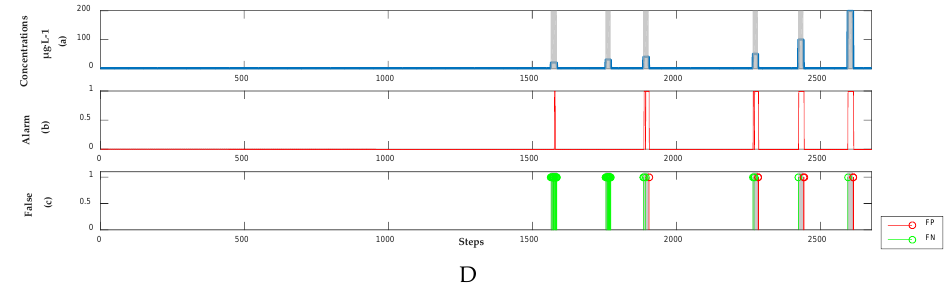
Figure 12. Detection results of the semi-supervised model without baseline drift correction. (Panel ( A )) The concentrations, alarm signals and FP points and FN points of phenol; (Panel ( B )) The concentrations, alarm signals and FP points and FN points of m-phenylenediamine; (Panel ( C )) The concentrations, alarm signals and FP points and FN points of hydroquinone; (Panel ( D )) The concentrations, alarm signals and FP points and FN points of resorcinol.